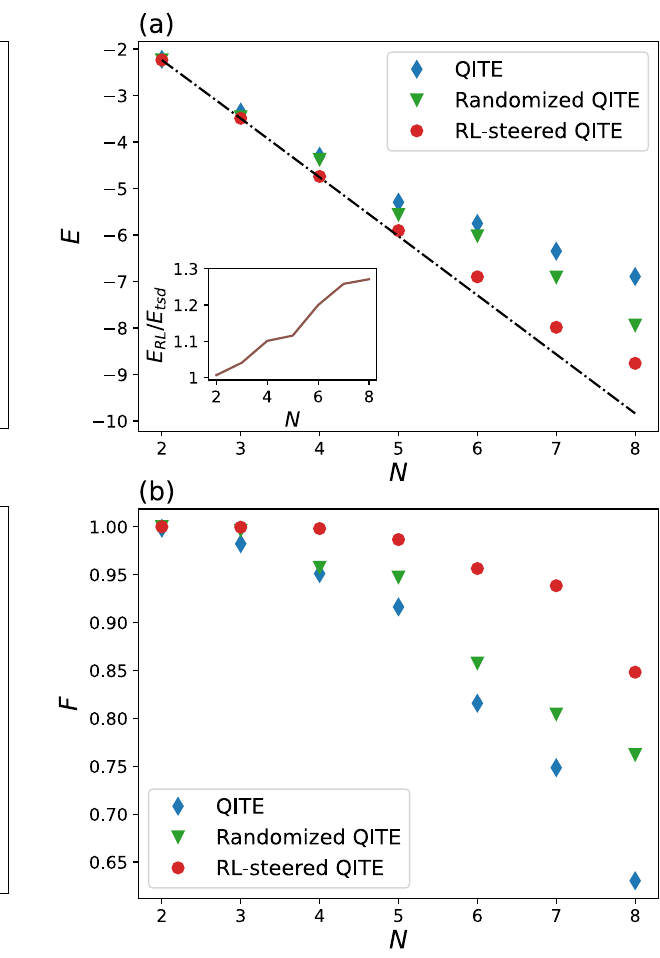
Fig. 3 Scaling of different QITE schemes. Blue diamonds represent the standard quantum imaginary time evolution (QITE); green triangles represent the randomized QITE; red circles represent the reinforcement learning (RL)-steered QITE. a Energy versus system size, and the energy ratio E RL / E std versus system size (inset). The black dash-dotted line represents the ground state energy. b Fidelity versus system